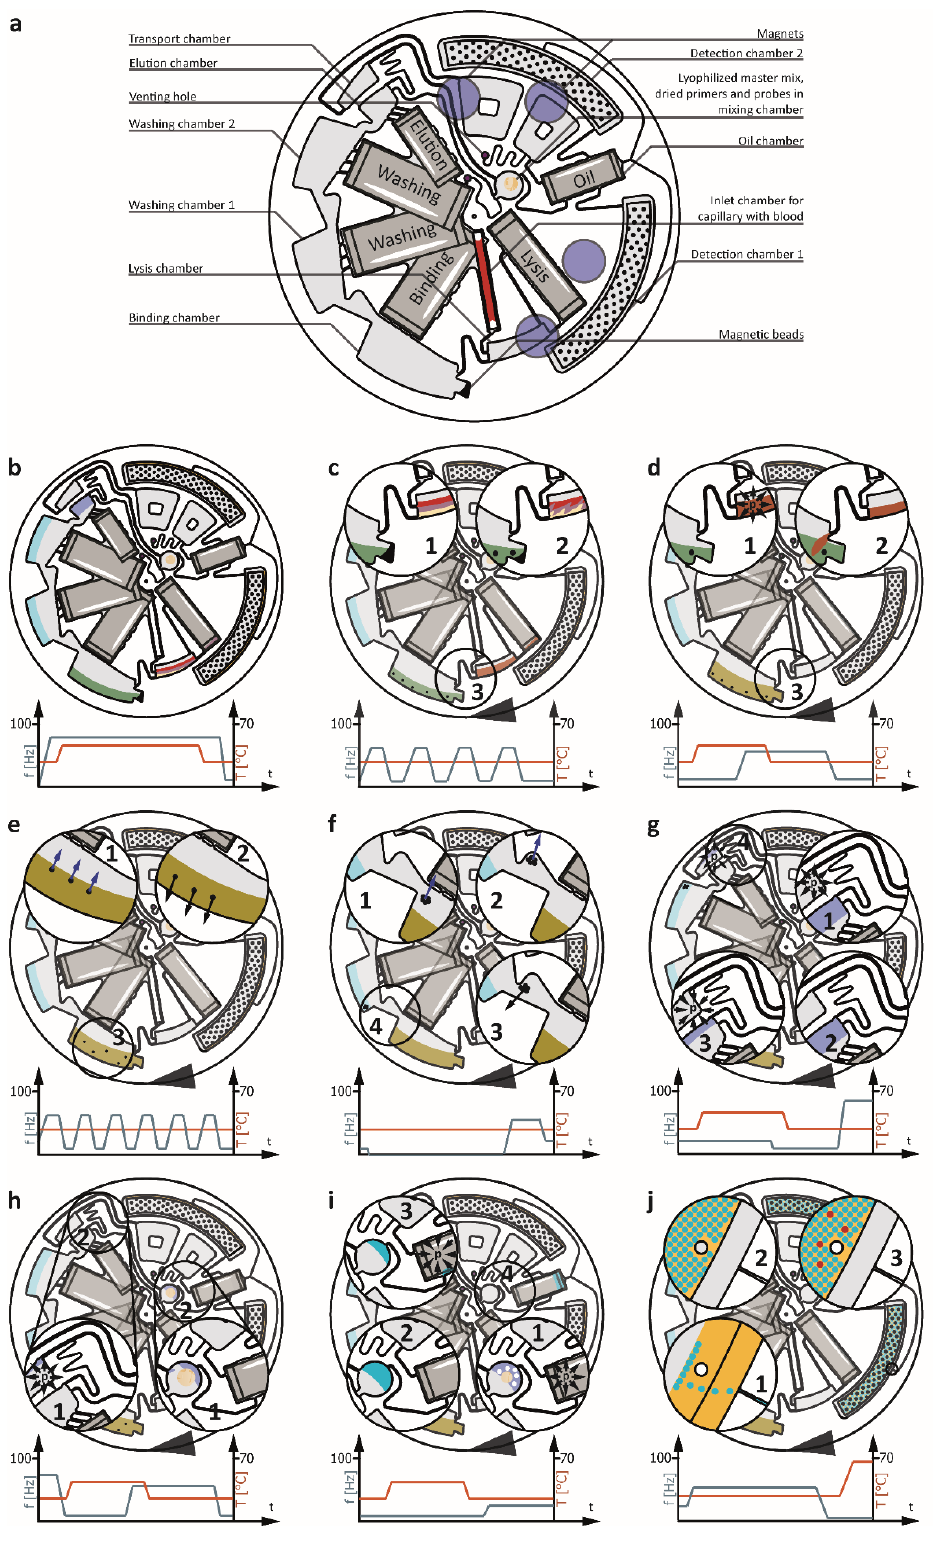
Figure 2. Complete workflow of the LabDisk. Blue arrows depict magnetic forces, whereas centrifugal forces are depicted by black arrows. Pneumatic pressure is represented by the letter p encircled with arrows. ( a ) Overview of the cartridge and pre-stored reagents. ( b ) Liquid release from stick-packs. ( c ) Lysis. ( d ) Liquid transport into the binding chamber. ( e ) Binding. ( f ) Magnetic bead transfer. ( g , h ) Elution transport into mixing chamber. ( i ) Pre-stored reagent mixing and transport into oil chamber. ( j ) Droplet generation by step emulsification and subsequent